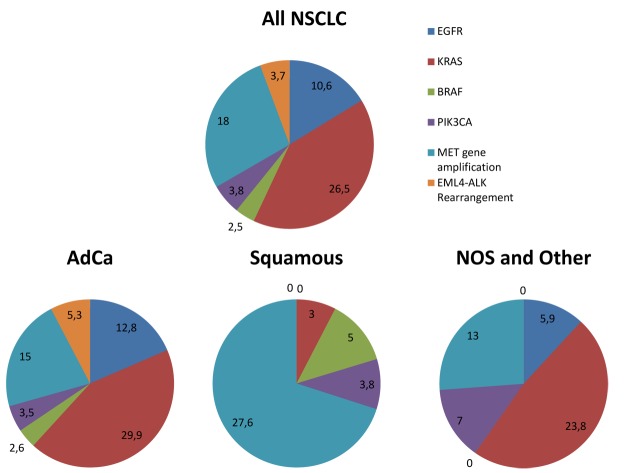
Pie charts representing the frequencies (%) of alterations of the examined genes in this cohort.Percentage of alterations for all the samples of the cohort (All NSCLC) and between the different histological types adenocarcinoma (AdCa), squamous cell carcinomas (Squamous), and other types (NOS and Other).